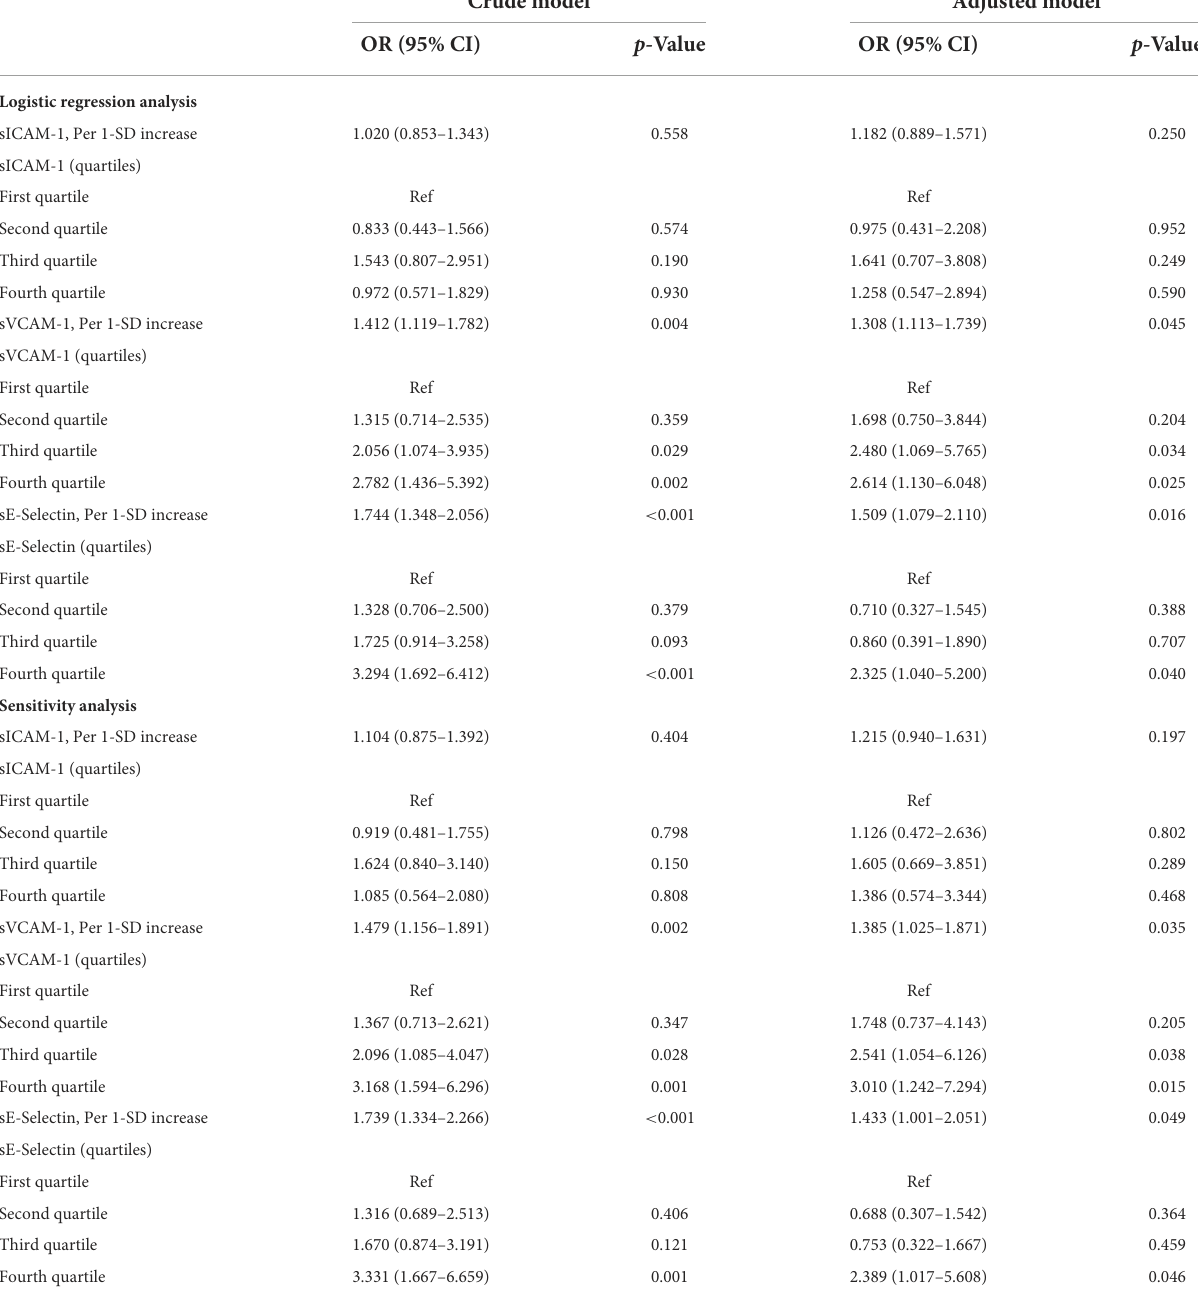
TABLE 2 The multivariate regression analysis for the associations of adhesion molecule markers with a 90-day poor